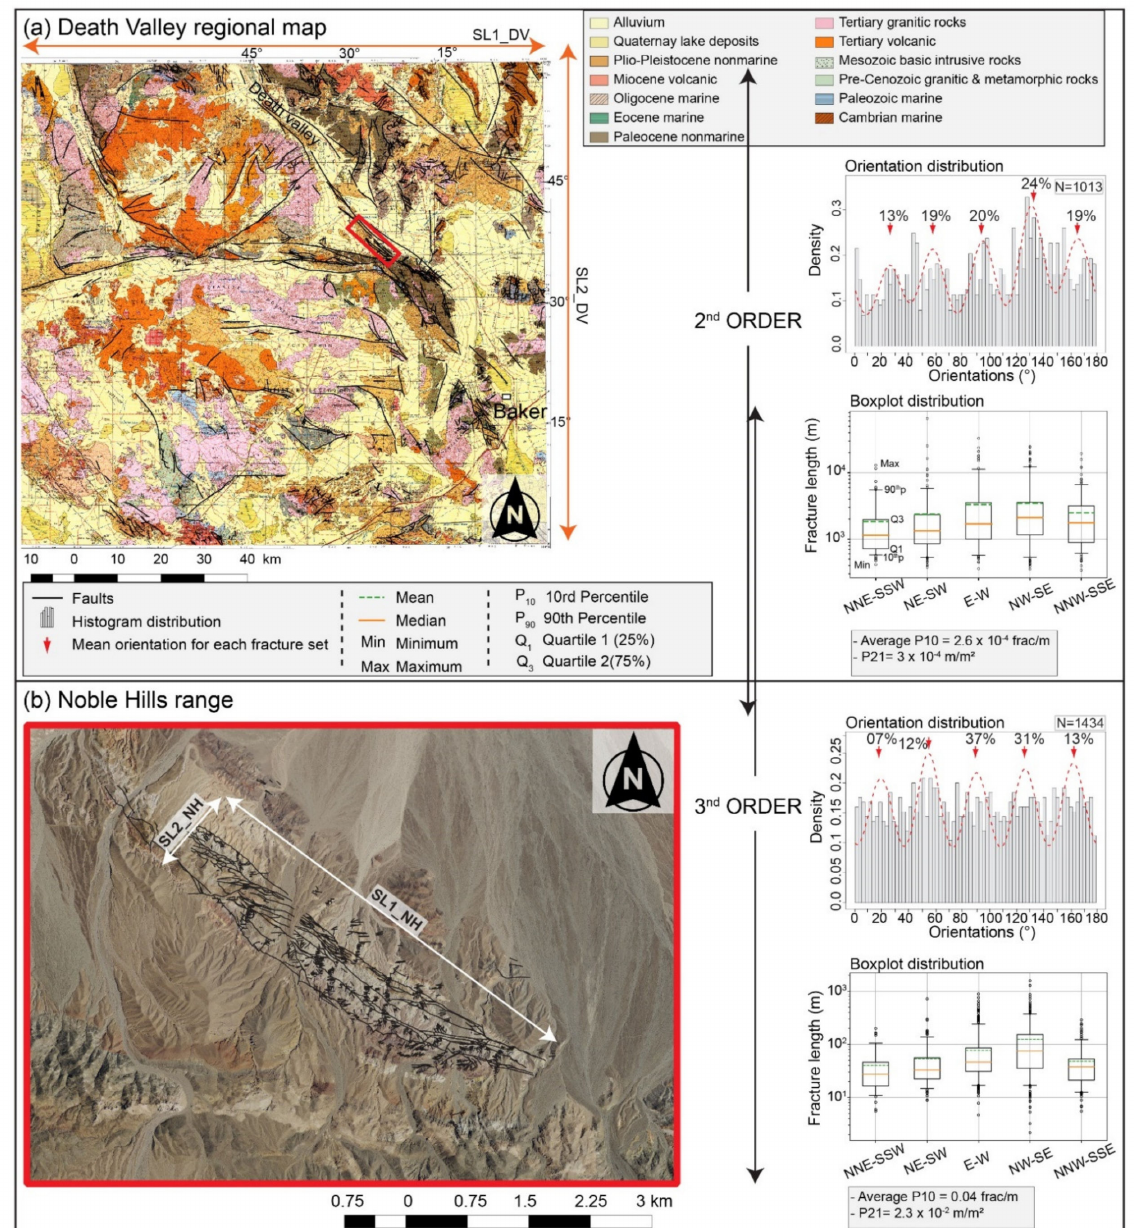
Figure 2. Fracture traces, orientation, and boxplot distributions from ( a ) DV geological map and ( b ) NH range map (in red rectangle for large scale location). The order of fractures magnitude were referred to the classification detailed in [30]. The first order referred to the faults larger 100 km length is not detected in this study. Each fracture map dataset is expressed in histogram for orientation distribution, and into boxplot for length distribution, according to the fracture orientations. Two scanlines (SL) were taken for every